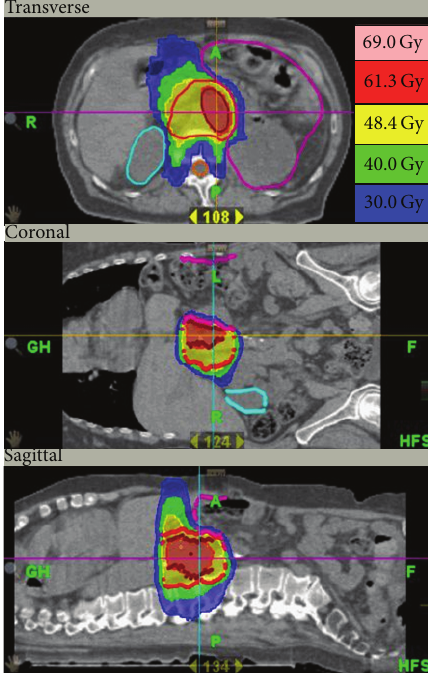
Figure 1: Radiation plan. Representative dose distribution of a Tomotherapy plan for a pancreatic recurrency, given in three orthogonal planes: the dark red contour delineates the macroscopic tumor (ascertained by PET) with a prescribed dose of 64.5 Gy. The planning target volume (PTV) is light red and includes the adjacent lymph nodes. The prescribed dose is 51Gy. Dose coverage of > 95% is achieved. The surrounding normal tissues liver, kidneys (light blue), intestine (magenta), and spinal cord (orange) are particularly spared. In this patient only a small part of the intestine ( < 100mL) is exposed to a dose > 30 Gy (blue region). Note the high conformality as well as the steep dose gradient from 60 below 30 Gy in selected